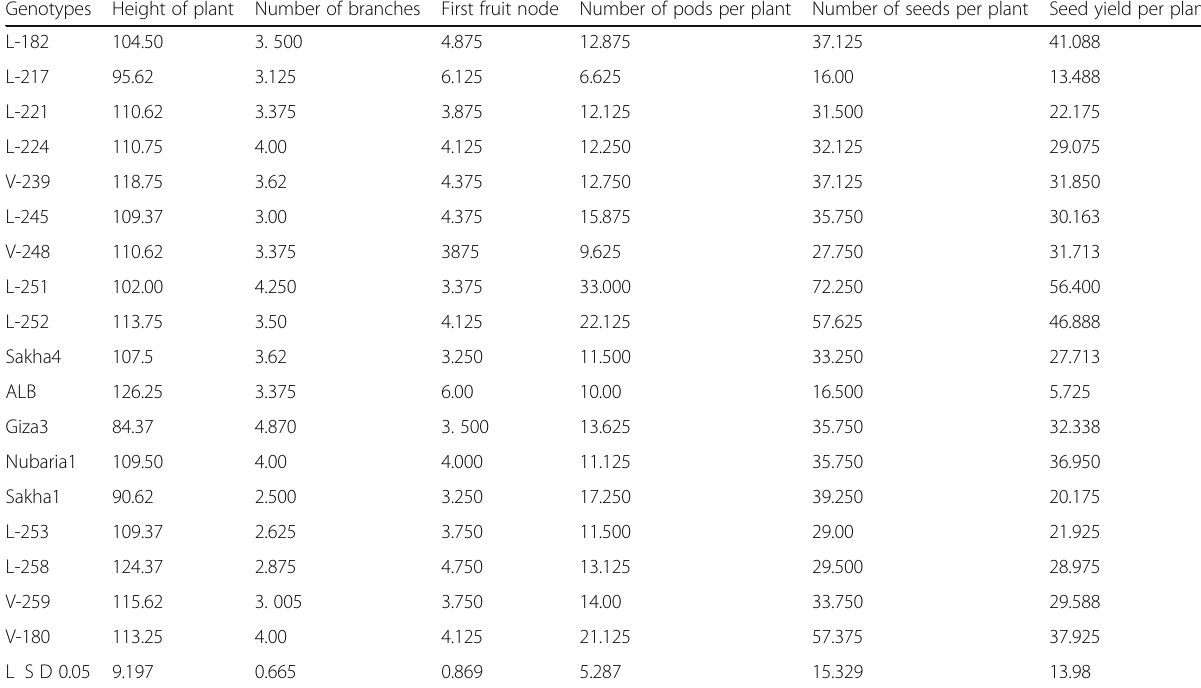
Table 3 Mean performance of the 18 faba bean genotypes as a combination of the two